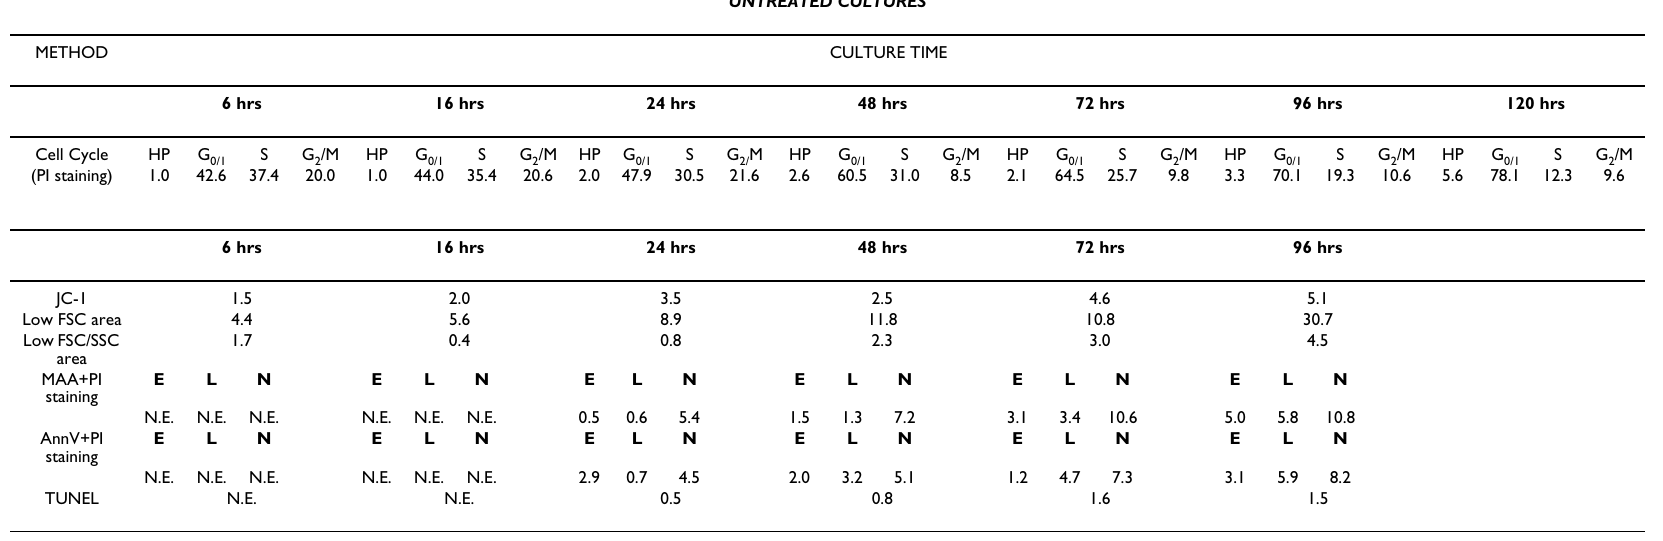
UNTREATED CULTURES